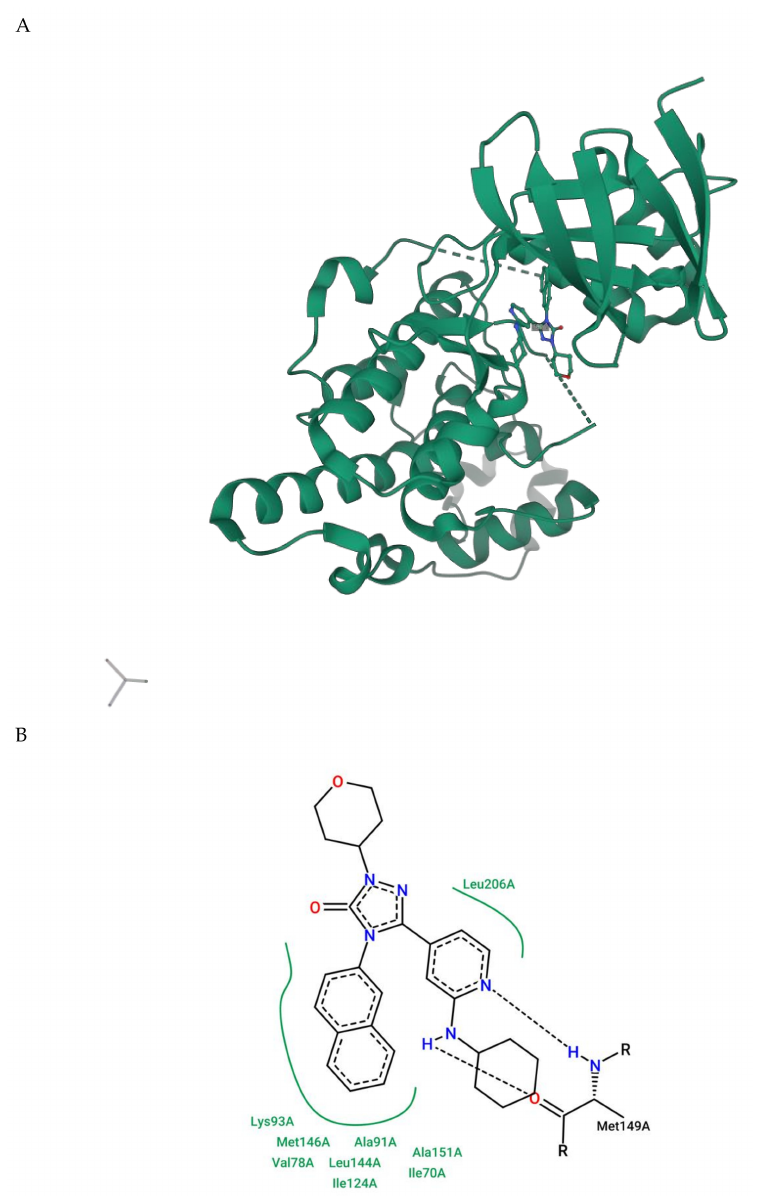
Figure 5. ( A ) Overview of the three-dimensional structure of the JNK3 interacting with its ligand (PDB code: 3OY1); ( B ) 2D protein-ligand interaction plot for 3OY1, emphasizing the interactions between the ligand and the residue Met149. The hydrogen bond (at atom level) is shown in dashed lines. Amino acids that do not interact with the ligand via hydrogen bond are shown in green. Water molecules are not shown. Plot automatically generated by ProteinsPlus using the PoseView tool based on the 2Ddraw